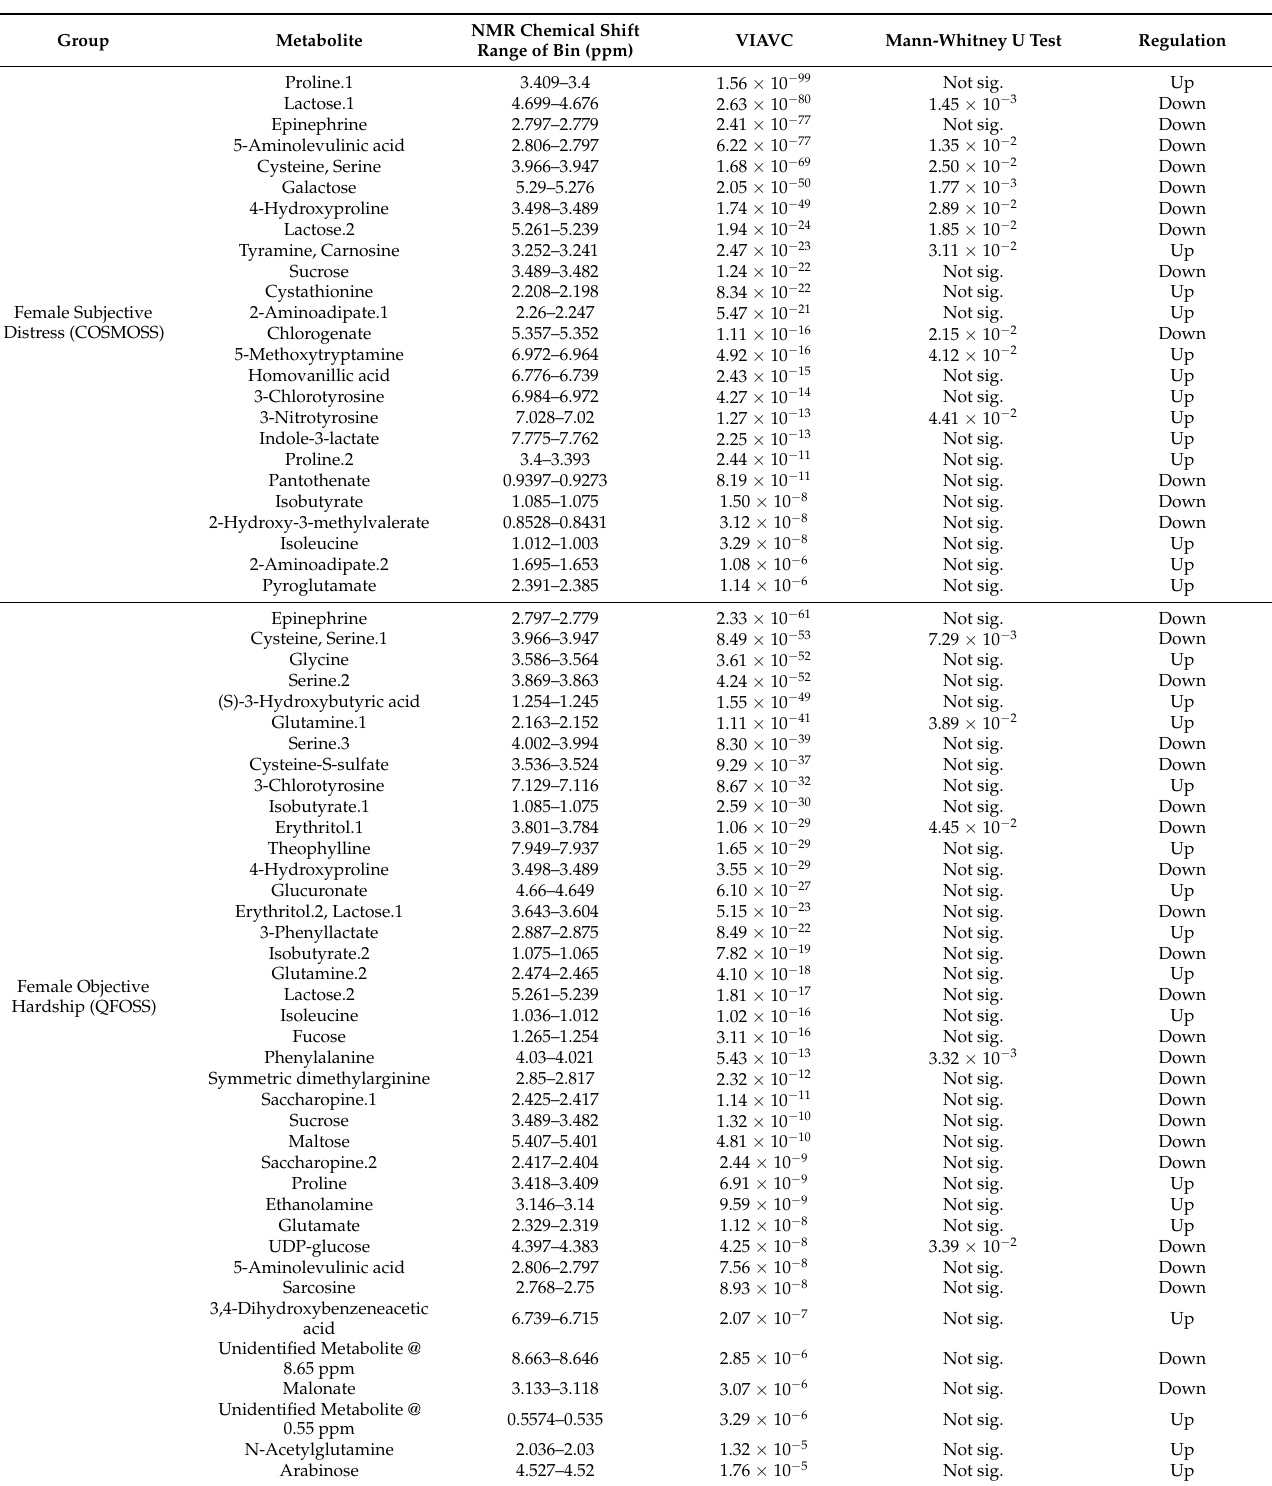
Table 2. Females: Statistically significant urinary metabolites identified by VIAVC or MW testing in the comparison of high and low maternal composite subjective distress and objective hardship in females. Significance was determined using a p -value equal to or less than 0.05. Metabolites are displayed in order of VIAVC p -value. Regulation relates to the high-stress group. Metabolite with more than one NMR resonance peak are represented in order of ppm as metabolite.1, metabolite.2,